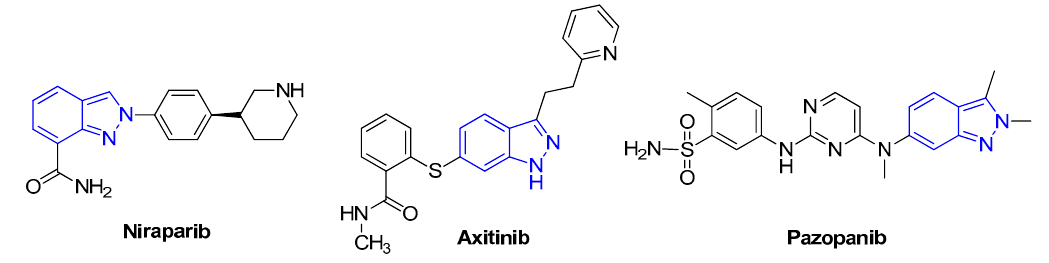
Figure 2. Indazoles containing anticancer drugs.